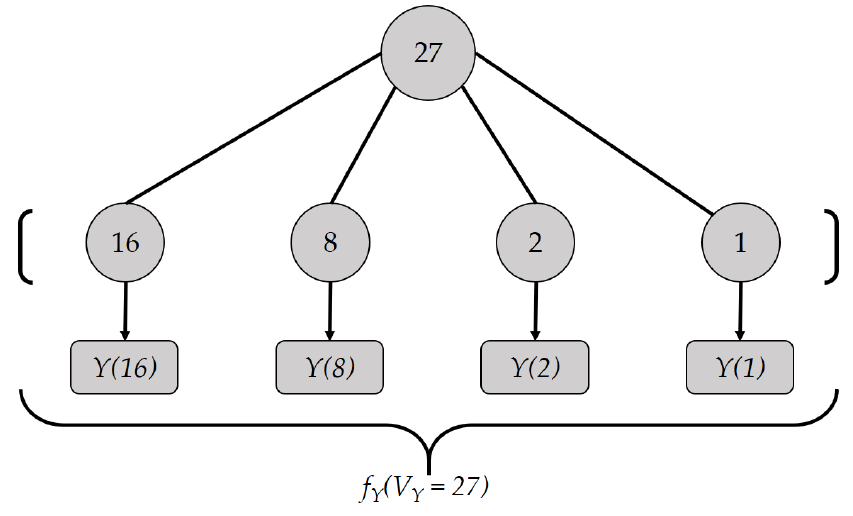
Figure 1. Encoding example: f Y ( V Y = 27 ) .